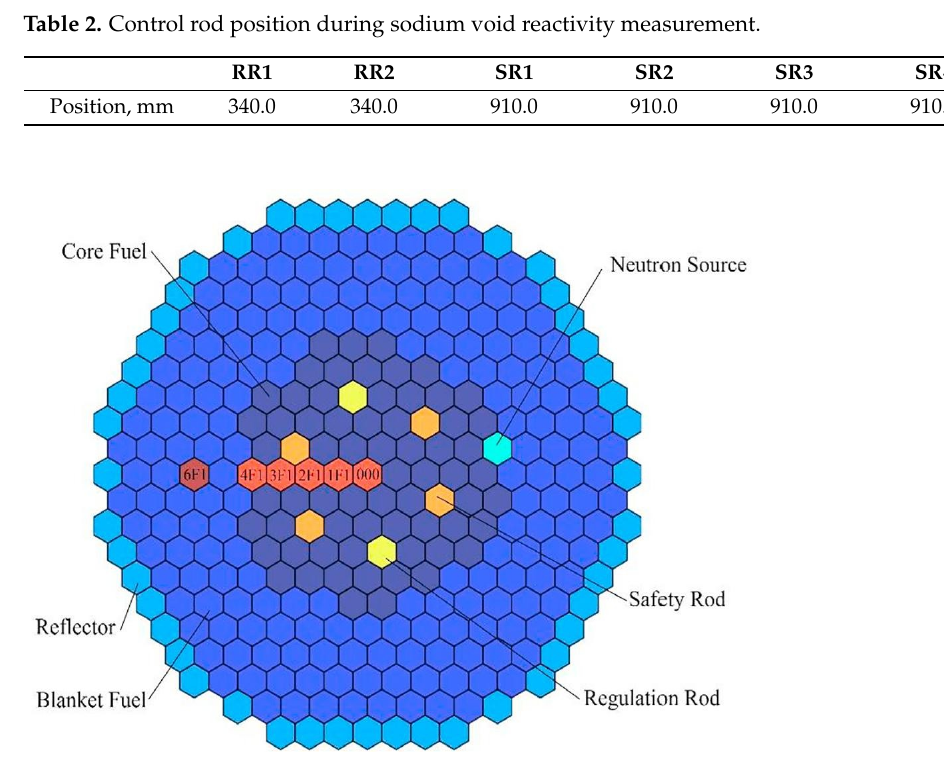
Figure 3. Radial layout of sodium void reactivity calculation.